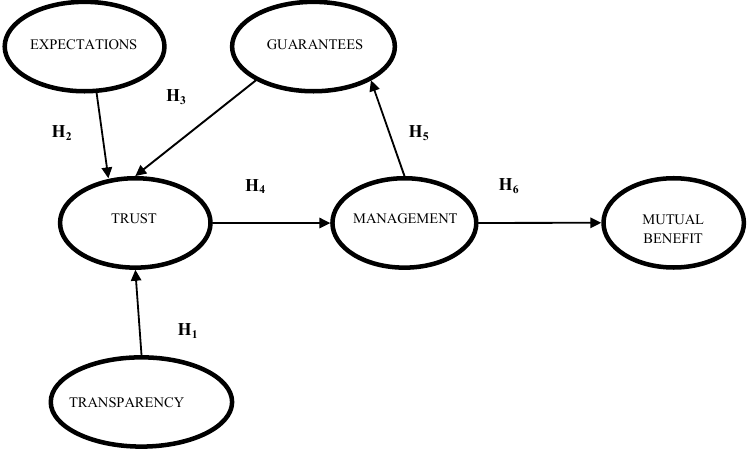
Figure 1. Collaborative and sustainable model for cash holding.